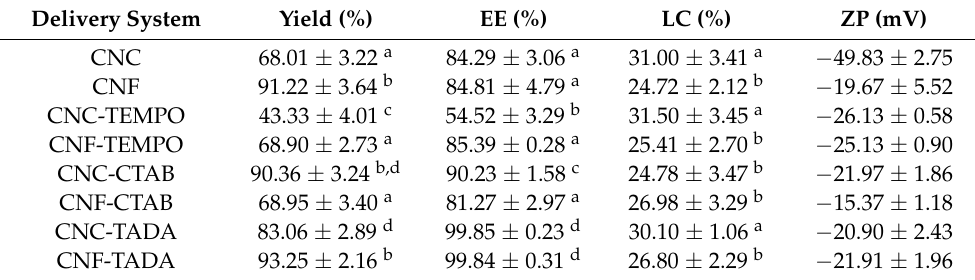
Table 3. Yield, encapsulation efficiency (EE), loading capacity (LC) and zeta potential (ZP) of modified and unmodified nanocellulose systems encapsulating curcumin. Delivery